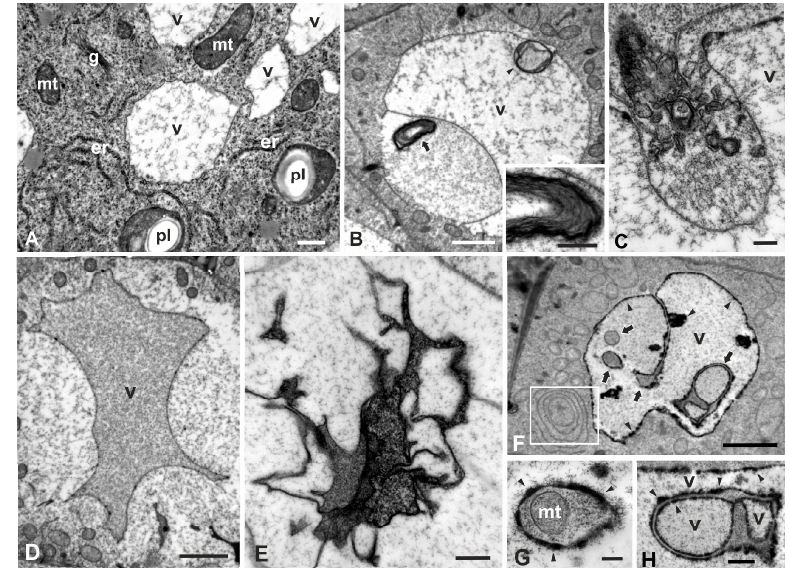
Figure 2. TEM micrographs of the effects of W on vacuoles of P. sativum root cortex cells. ( A ) Control. Small vacuoles (v) occur among endoplasmic reticulum (er), plastids (pl), mitochondria (mt) and Golgi bodies (g). ( B – D ) 200 mg/L W, 12 h. ( B ) A vacuole (v) containing a spherical membranous structure (arrowhead) and a large engulfment filled with granular material and a multilamellar body (arrow), part of which is magnified in the inset. ( C ) Engulfment of membranous, vesicular and amorphous material within a vacuole (v). ( D ) A collapsed vacuole (v) detached from the surrounding cytoplasm and filled with granular dense material. ( E – H ) 200 mg/L W, 24 h. ( E ) Accumulation of complicated membranous structures containing dense amorphous material within a vacuole. ( F – H ) Atypical vacuole (v) bearing transvacuolar cytoplasmic strands and protuberances (arrows), some of which are magnified in G and H showing the entrapment of a mitochondrion ( G , mt) or complicated structures ( H ). All membranes are lined on the vacuolar face with electron-dense deposits (arrowheads). Outlined area is magnified in Figure 3B. Scale bars: A = 1 µ M; B, D = 2 µ M; B inset, E, H = 0.5 µ M; C, F, G = 0.2 µ